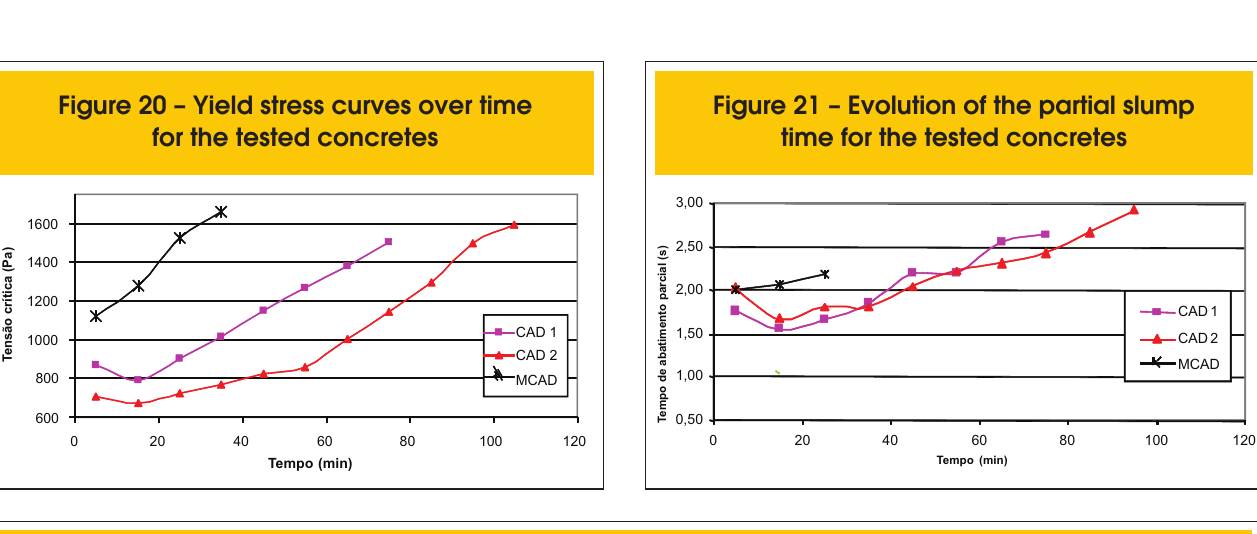
Table 19 – Partial slump time determined by the modified slump test over time for the tested concretes